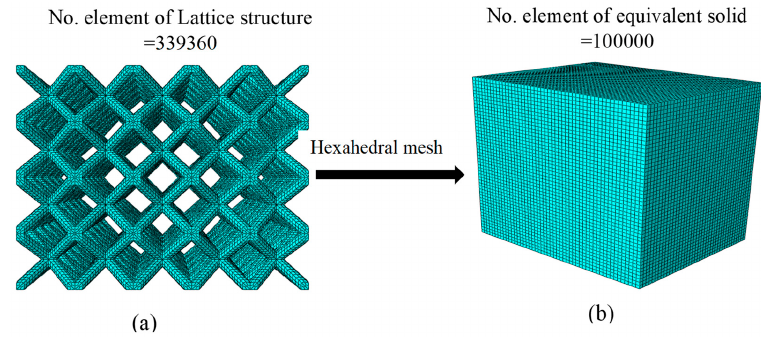
Figure 12. Full-FEA simulation for ( a ) LCS; and ( b ) the equivalent solid.